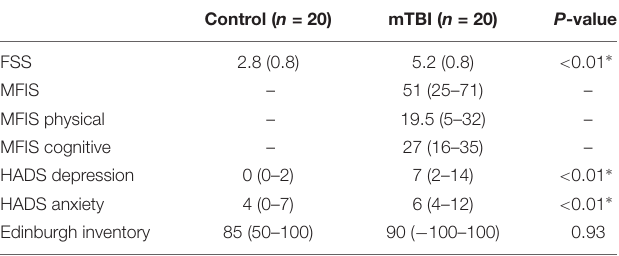
TABLE 2 | Questionnaire scores.